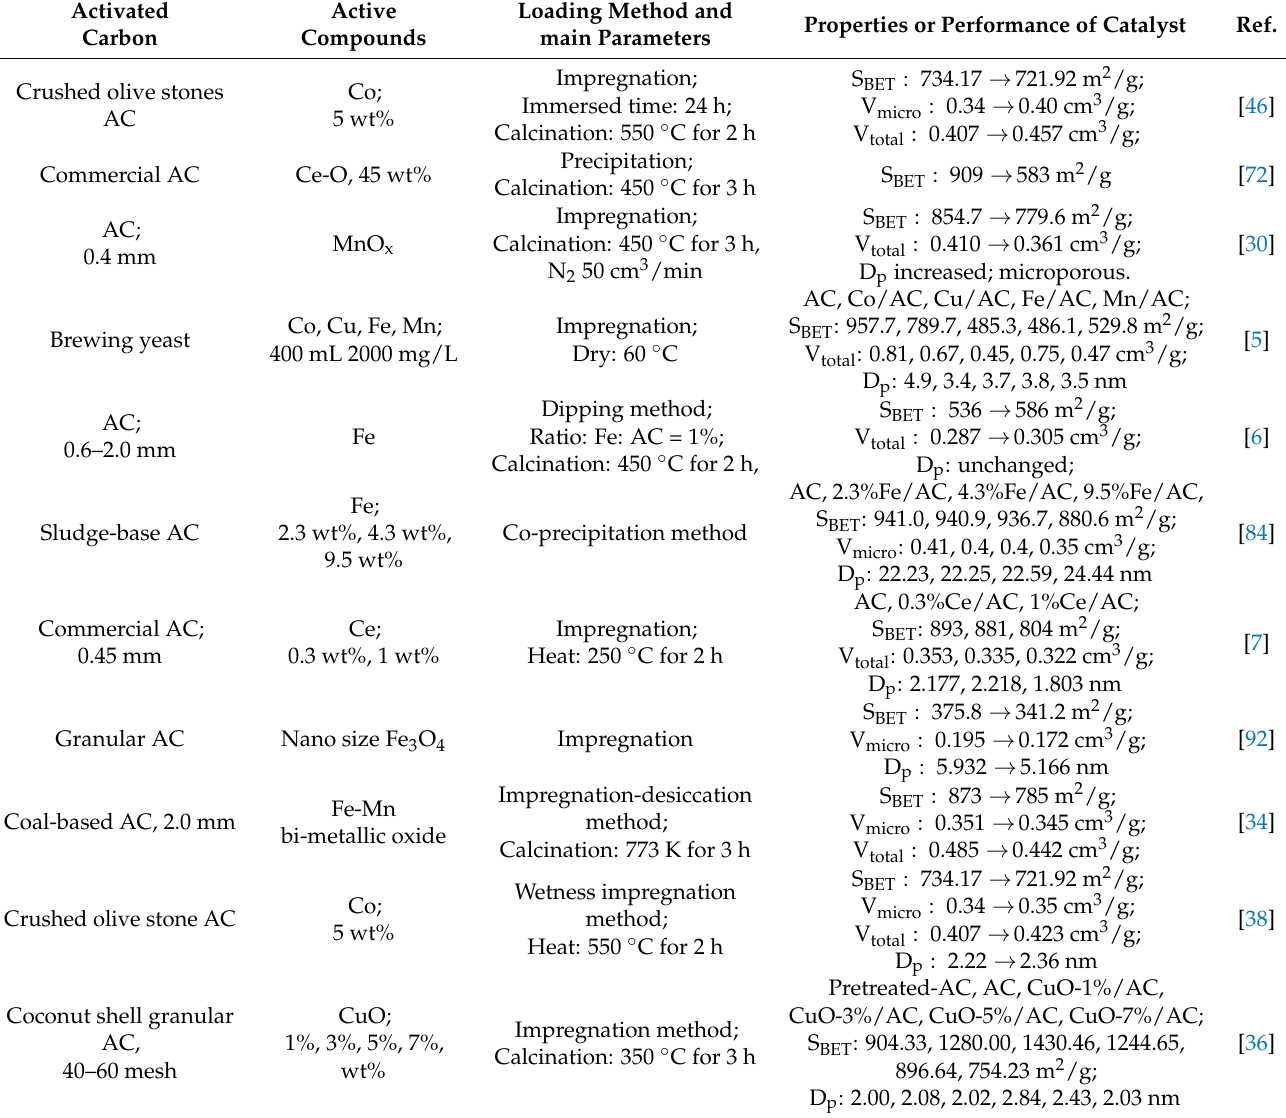
Table 3. Effect of loading on the properties and performance of activated carbon